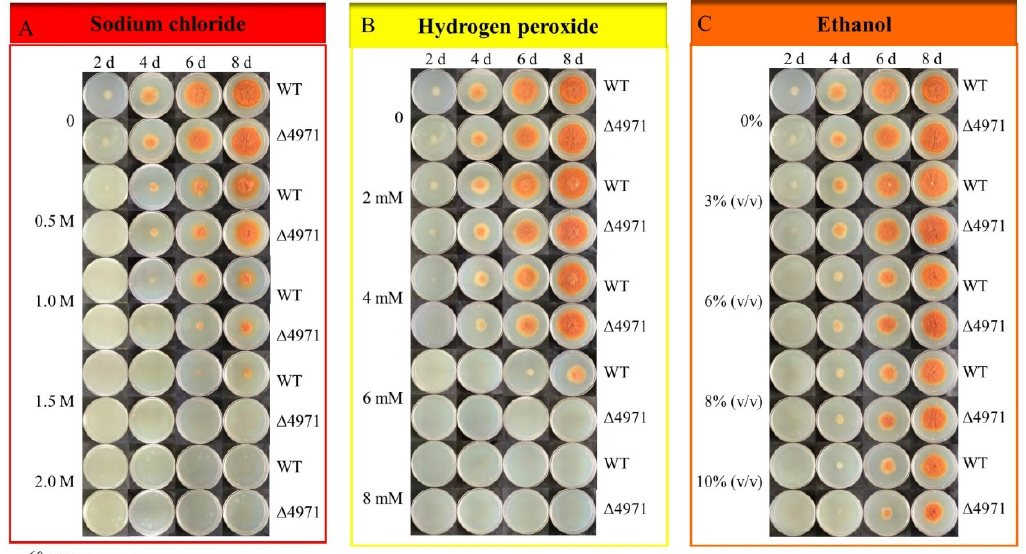
Figure 3. The mRNA relative level of gene monascus _4971 in mutant strains ( A ), the relative value of total monascus pigments production by different mutant strains ( B ).